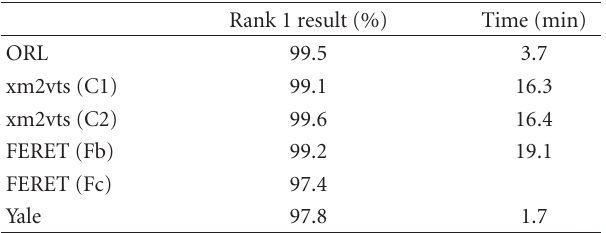
Table 2: The results of 4-component size 25 × 25 for the new method.